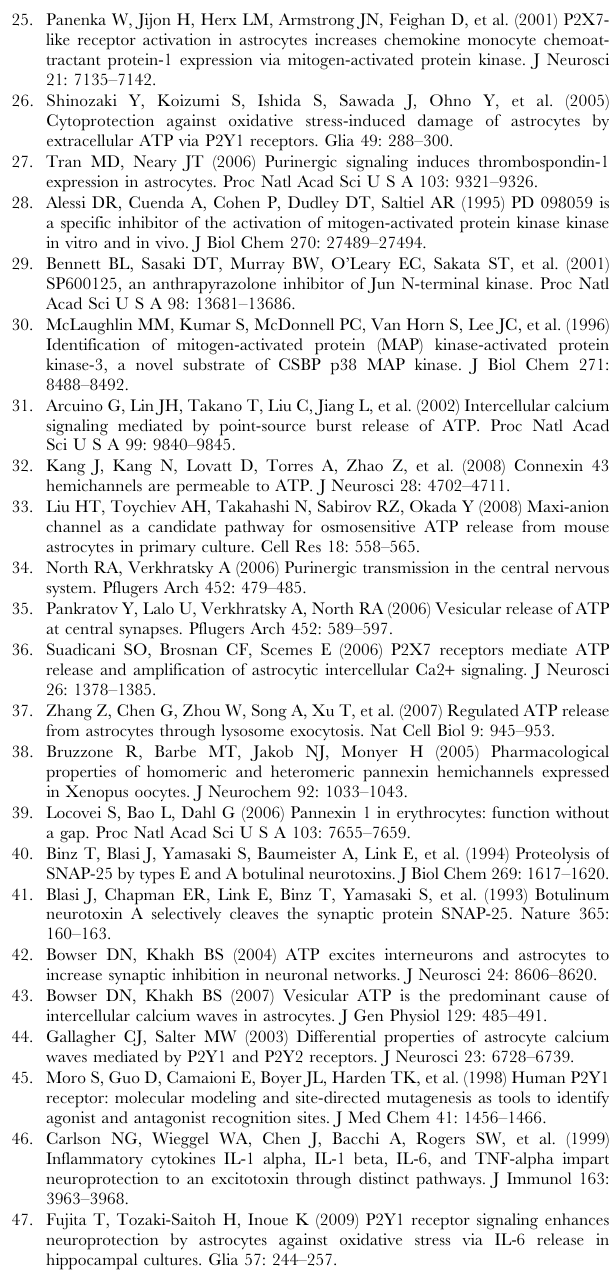
Figure S1 Differences in Ca 2 + responses to 2MeSADP and UTP in WT and P2Y 1 R KO mice. ( A ) Typical Ca 2 + responses to the P2Y 1 R agonist 2methyl-thio-ADP (2MeSADP) astrocytes obtained from WT mice (upper traces) and those